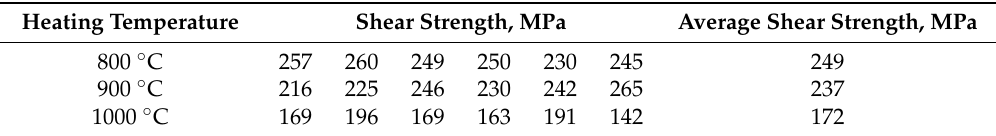
Table 4. The interfacial shear properties of the Ti/steel clad plates at various heating temperatures. Heating Temperature Shear Strength,